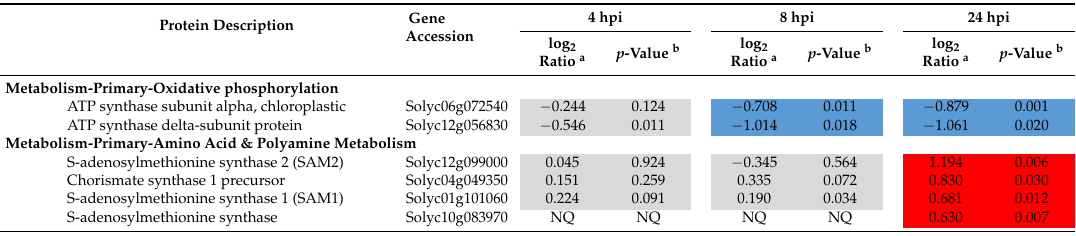
Table 4. Protein involved in other primary and secondary metabolisms with significant change in abundance at 4, 8, 24, hpi of Pst